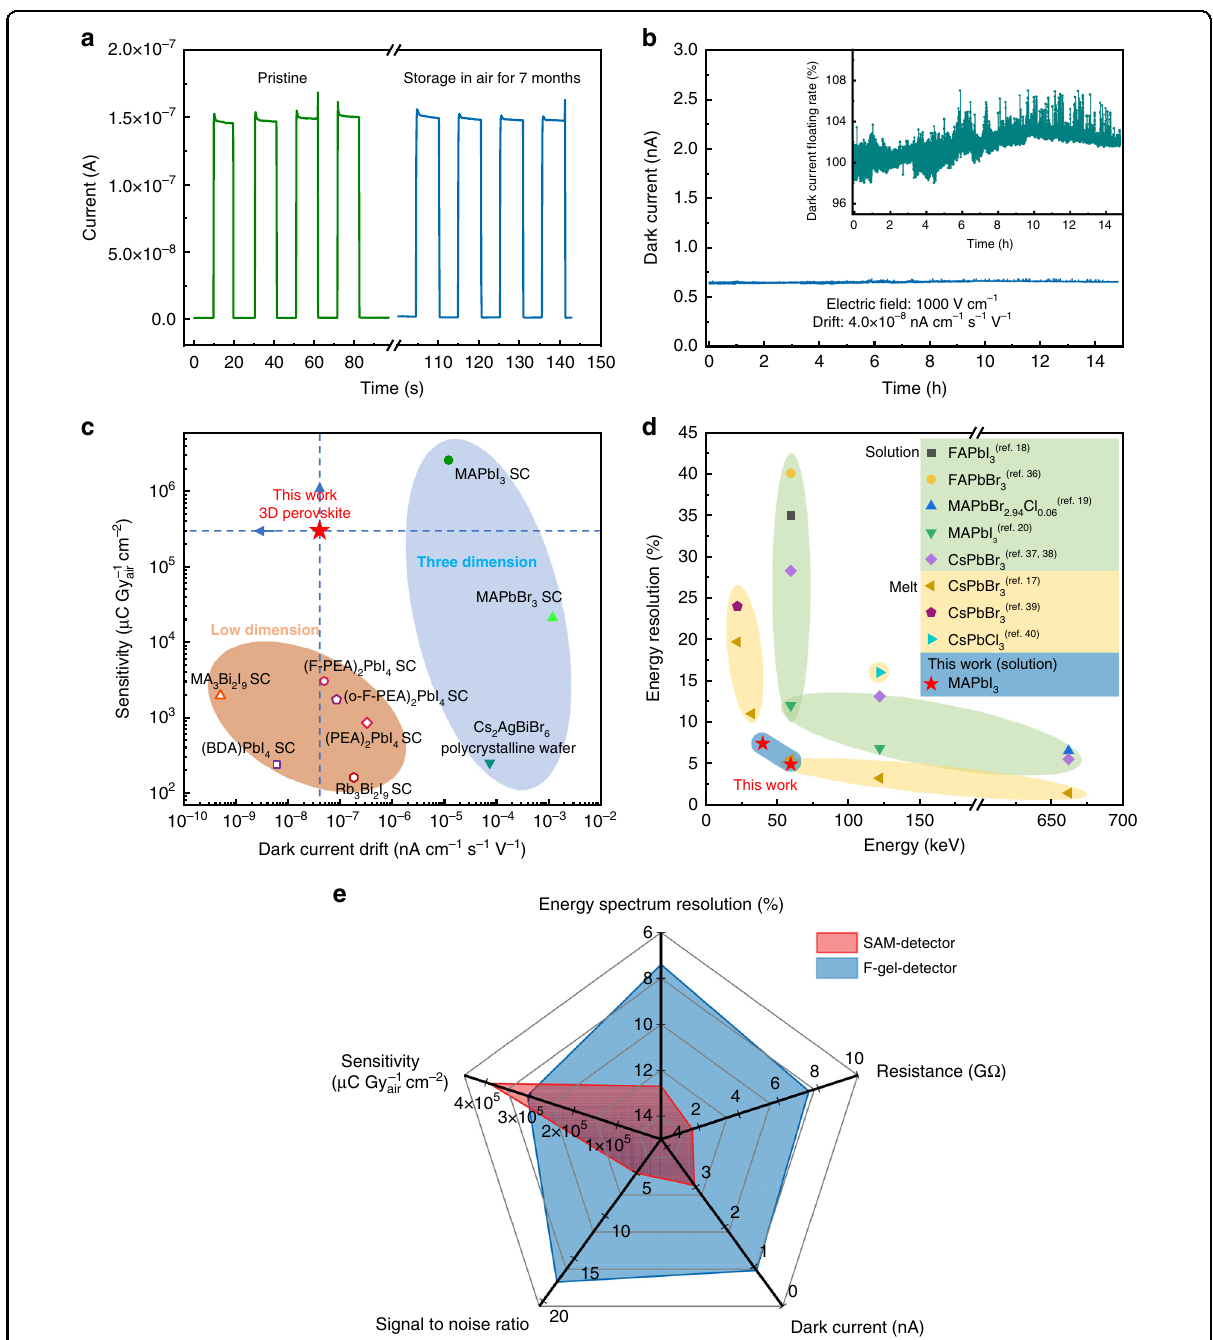
Fig. 5 Device stability and performance comparison. a Storage stability of F-gel-detector. b Dark current output as a function of time for the devices based on F-gel-SC under 1000 V cm − 1 electric fi eld (inset: dark current fl oating rate). c Summary of the sensitivity and dark current drift of various kinds of MHP radiation detectors. d ER of the reported MHP-based radiation detectors. e Radiation detection performance comparison between the F-gel-detectors and